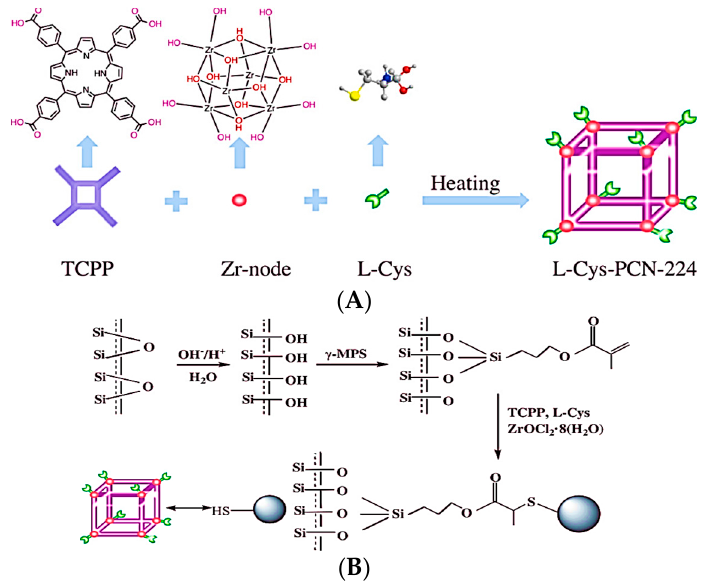
Figure 20. ( A ) Scheme of the L-Cys-PCN-224 synthesis process. ( B ) Fabrication of L-Cys-PCN-224- bonded OT-column. Reprinted (adapted) with permission from [166]. Table 3. Chiral MOFs as chiral stationary phases for CEC.